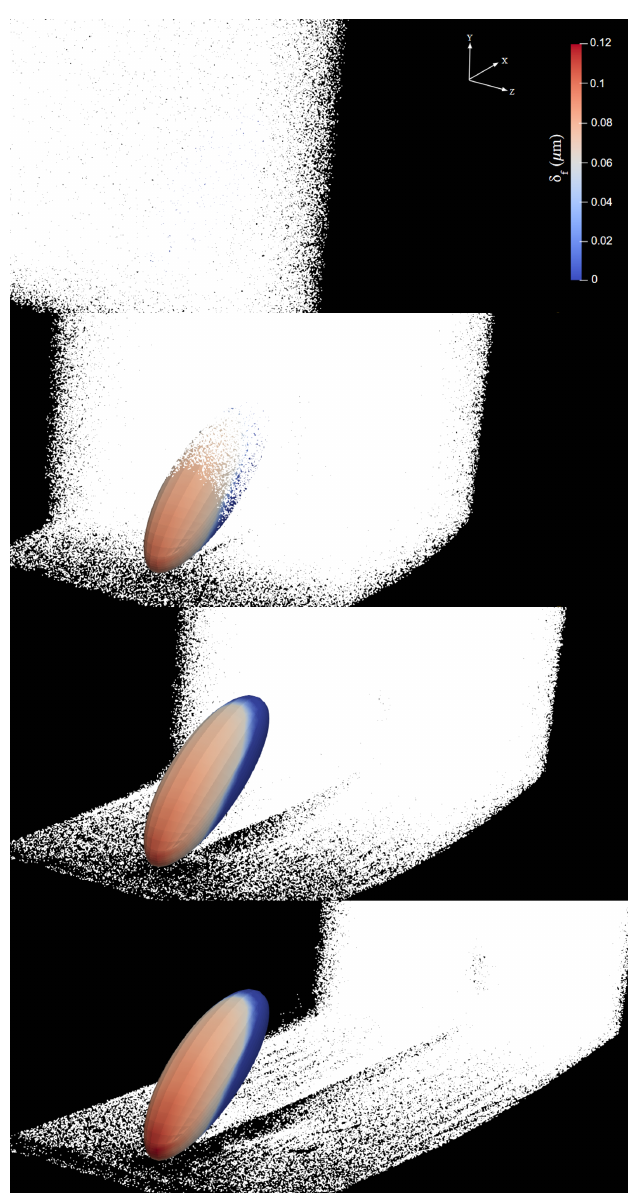
Figure 9. Temporal evolution of liquid-film thickness δ f formed by water droplets (represented by white dots) for α = 40 deg (run A6). From top to bottom, panels correspond to t = 3.5ms, 12.5ms, 17ms, and 20ms after droplets injection. An animation is available in the Supplementary Materials